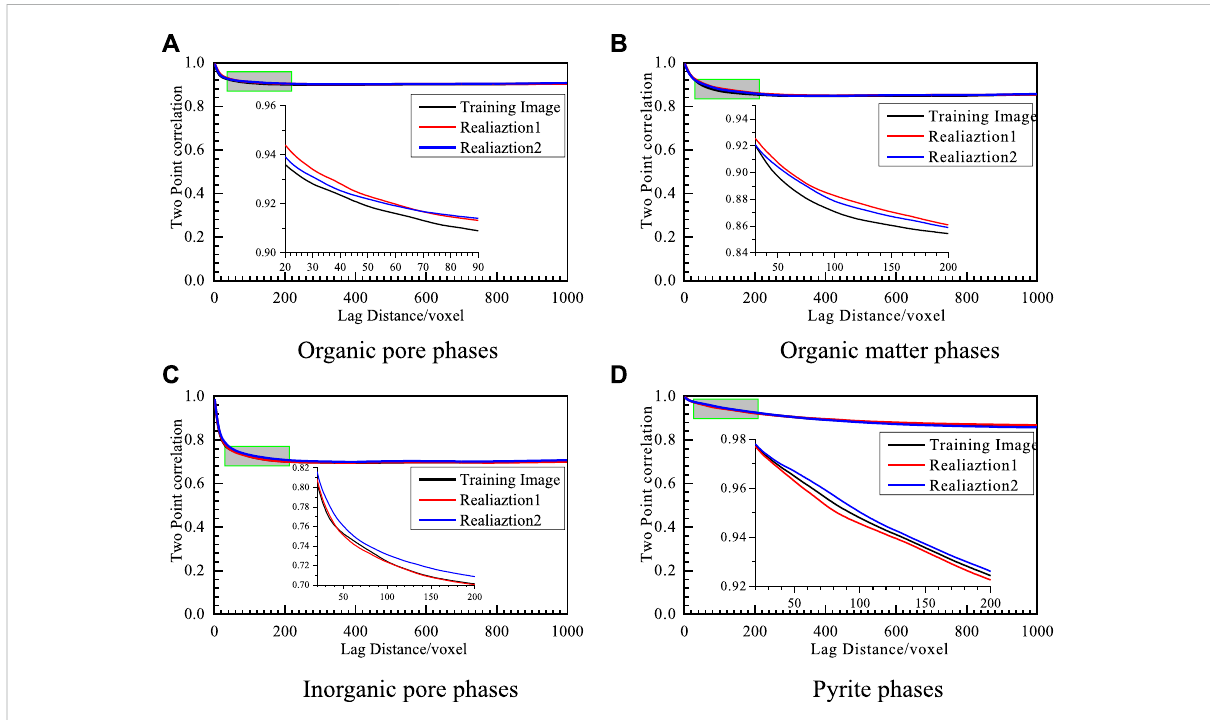
FIGURE 5 Two-point correlation functions of different phases for the training image and two realizations generated by the suggested model, (A) , (B) , (C) , and (D) are comparisons of two-point correlation functions of the training image and different realizations (realizations one and 2) for organic pore, organic matter, inorganic pore, and pyrite phase, respectively. Black represents the training image, red represents realization one and blue is realization